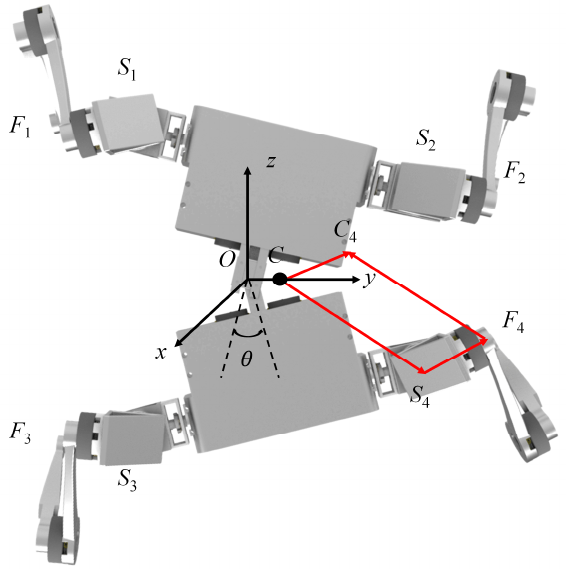
Figure 3. The single chain affecting the trunk workspace.